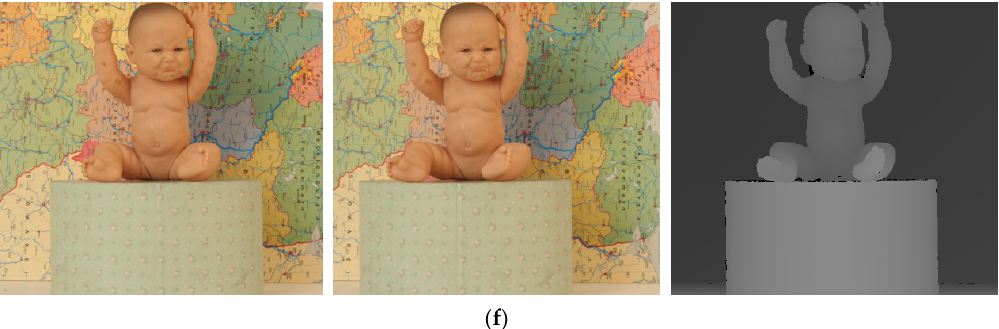
Figure 7. The experimental images: sequentially, the right image, left image and ground truth. ( a ) Moebius, ( b ) Flowerpots, ( c ) Reindeer, ( d ) Cloth2, ( e ) Midd1, and ( f ) Baby1.